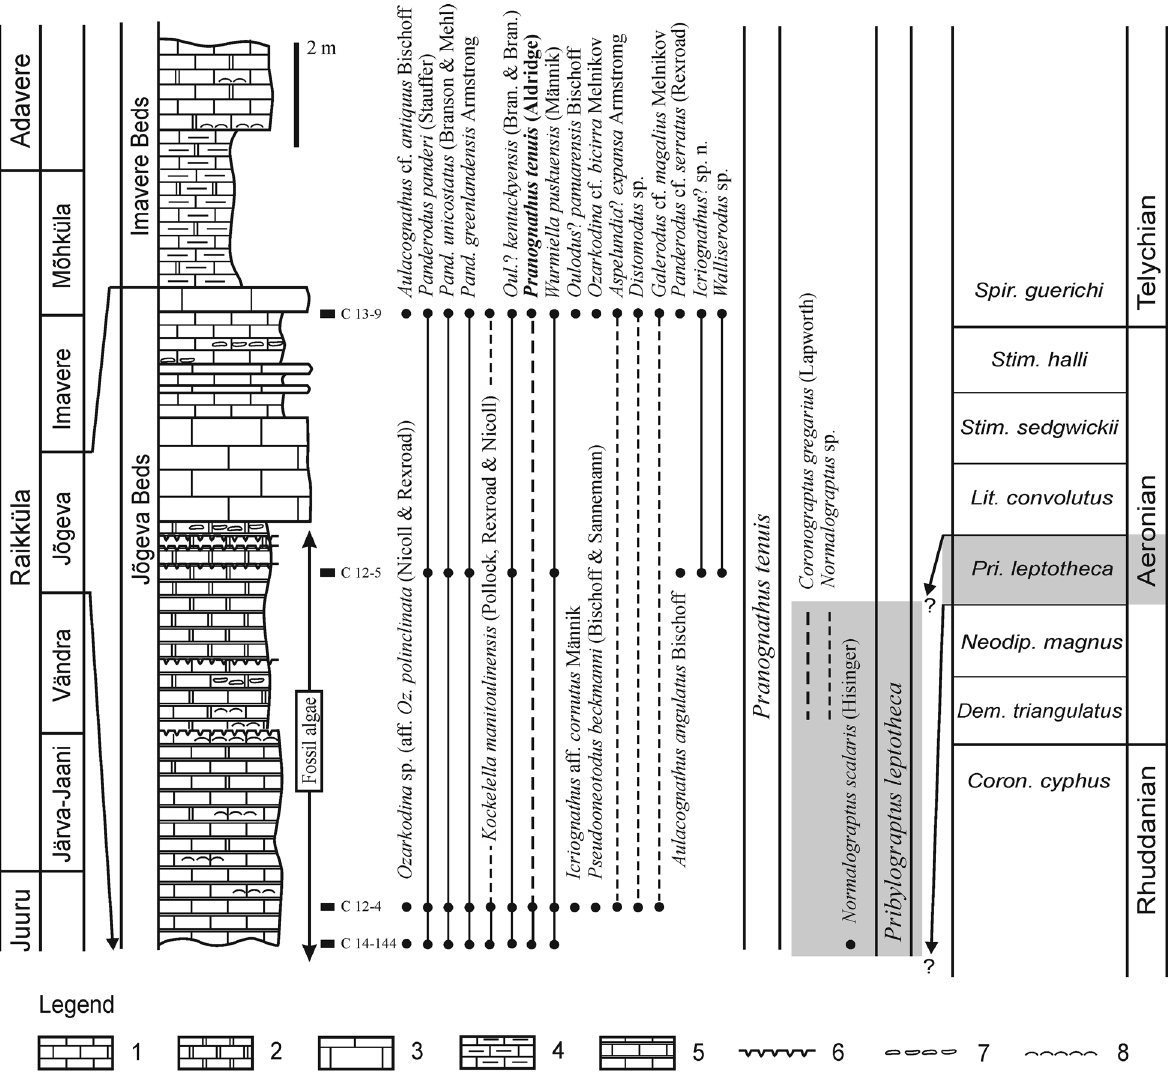
Fig. 2. The studied Kalana quarry section. From left to right: regional stages; beds in the Nurmekund Formation; lithology (modified from Ainsaar et al. 2014); conodont samples; distribution of conodonts; conodont biozone recognized; distribution of graptolites; graptolite biozone recognized; Aeronian graptolite biozonation (after Loydell 2012). Grey interval marks the identified graptolite biozone. Legend: 1, limestone (wackestone and packstone); 2, dolomitized wackestone and packstone; 3, limestone (grainstone); 4, argillaceous limestone (wackestone); 5, intercalation of different limestones and dolomitized limestones (mainly wackestone and packstone) with kerogenous laminae and thin interbeds; 6, pyritized discontinuity surfaces; 7, lithoclastic tempestites; 8, coquinal interbeds. Abbreviations: Coron ., Coronograptus ; Dem ., Demirastrites ; Lit ., Lituigraptus ; Neodip ., Neodiplograptus ; Pri ., Pribylograptus ; Spir ., Spirograptus ; Stim ., Stimulograptus